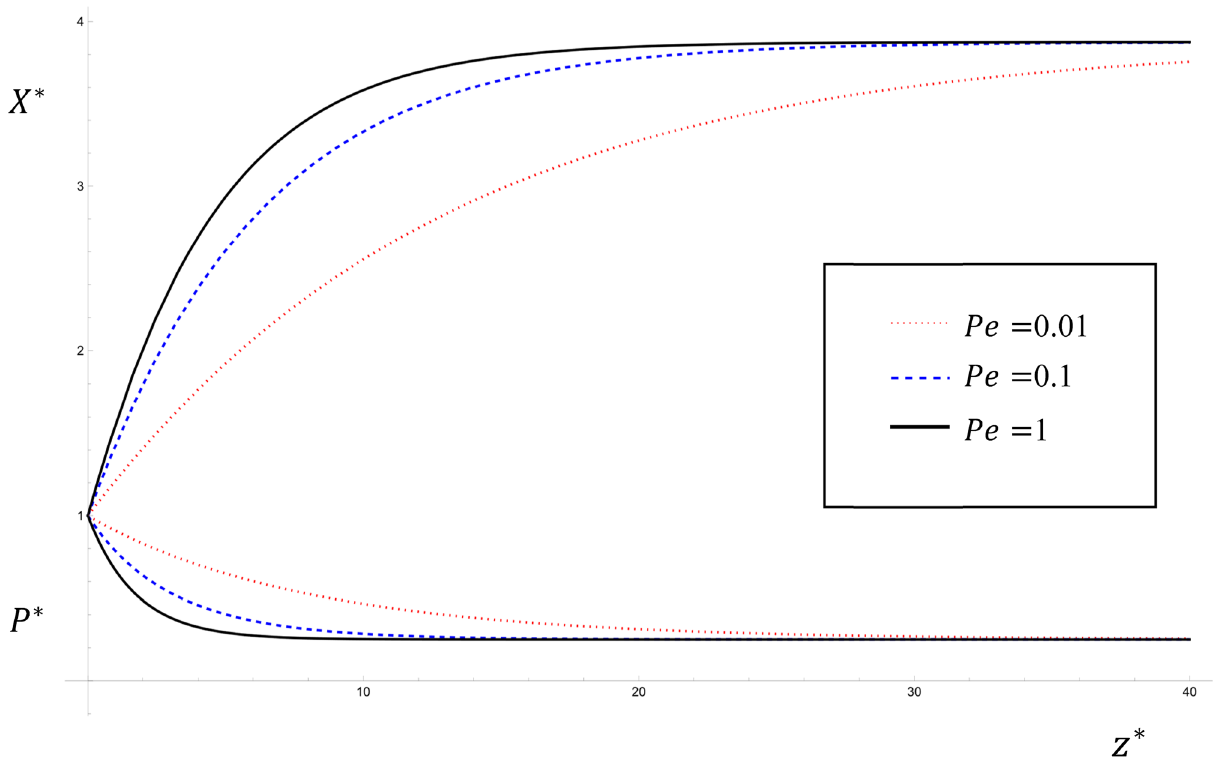
Figure 6. The variations of P ∗ and X ∗ with Peclet number for Pe solutions given by Eqs. (28, 29).